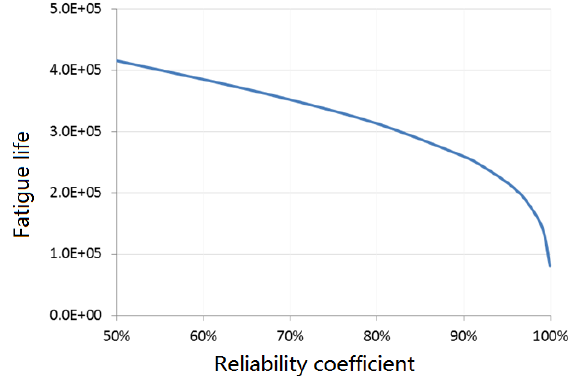
Figure 11. Fatigue lives under different reliability levels.